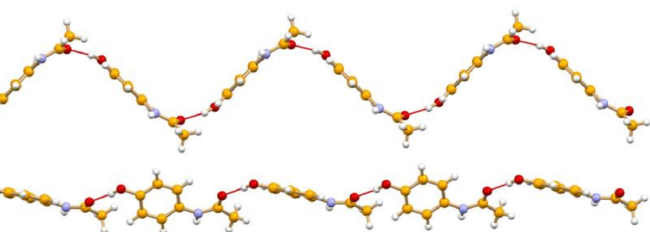
Figure 3. Hydrogen bonded chains in paracetamol Form I ( top , refcode HXACAN04) and Form II ( bottom , refcode HXACAN21).